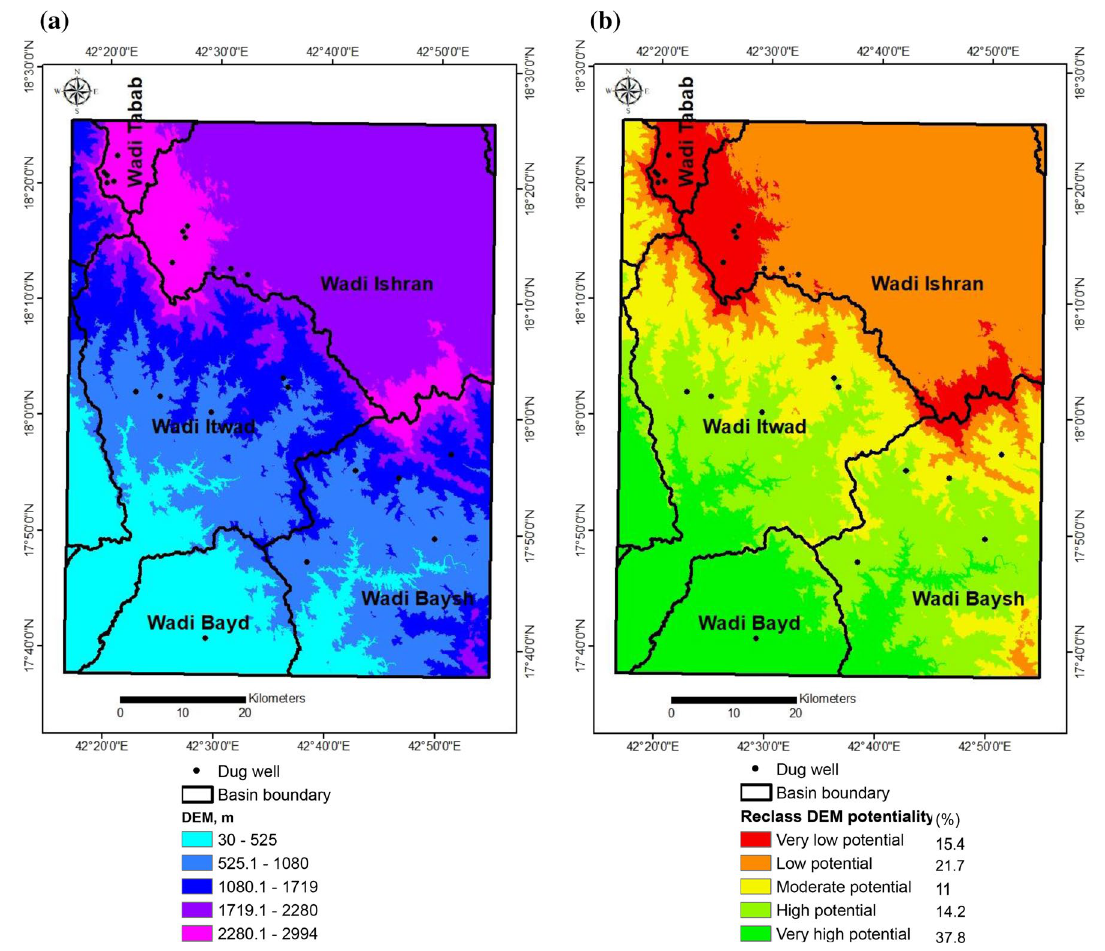
Fig. 5 a Topography and b reclassified topography of the study